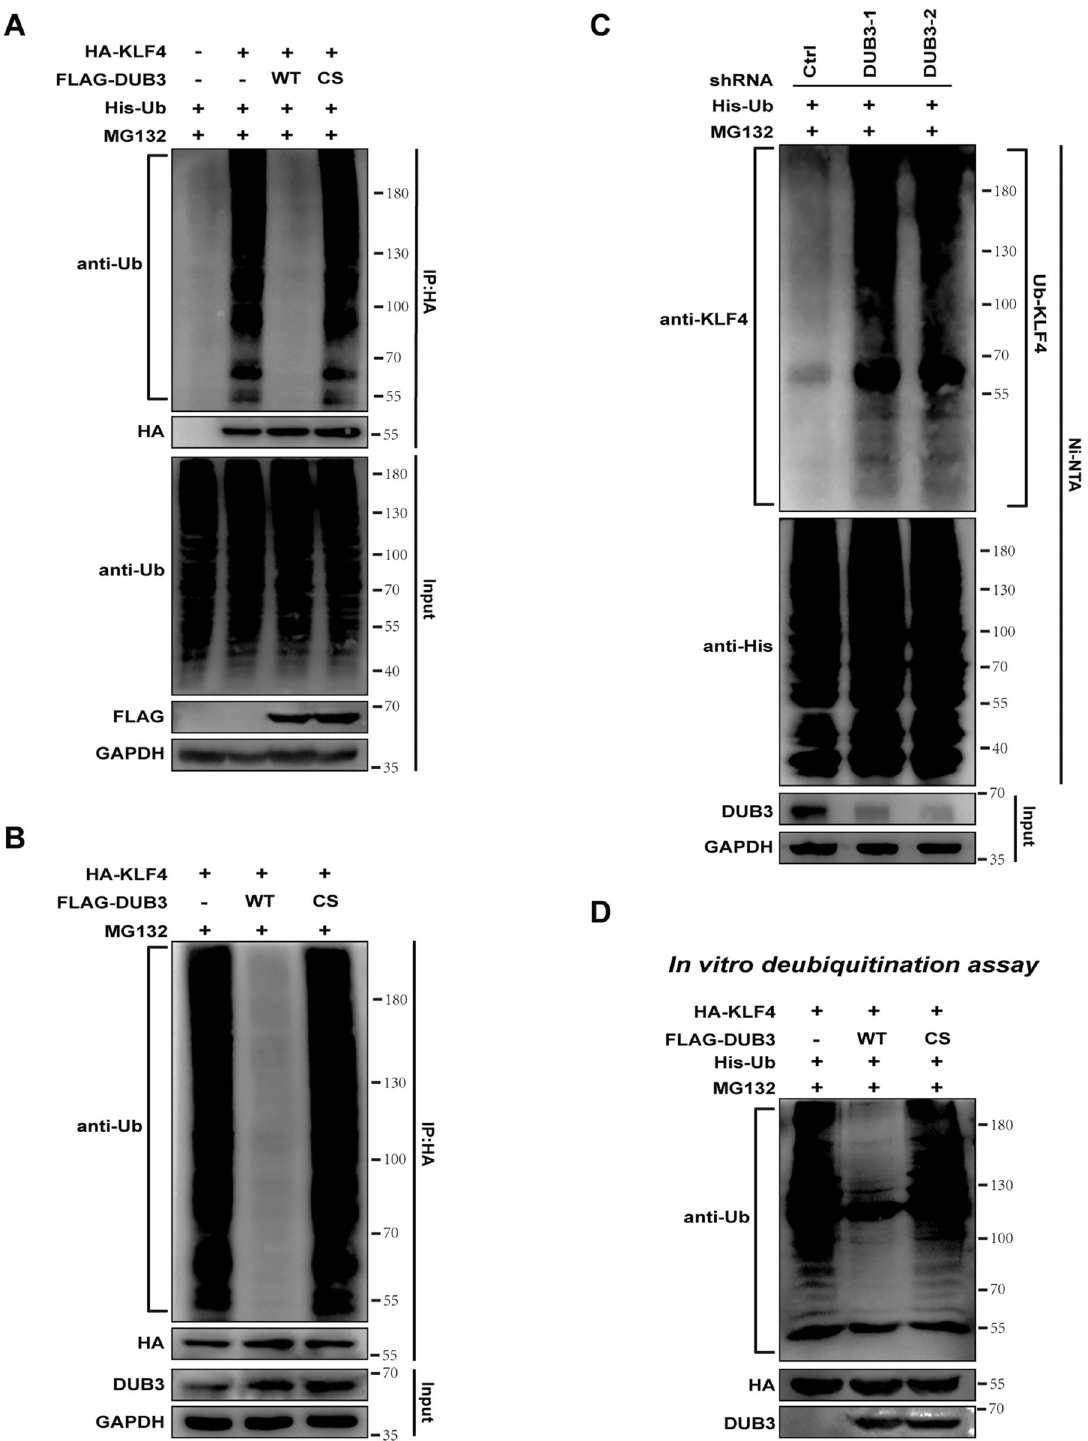
Fig. 3 DUB3 deubiquitinated KLF4 intracellularly and extracellularly. A HEK293T cells were transfected with vectors expressing HA-KLF4, wild-type FLAG-DUB3, FLAG-DUB3 mutant, or His-ubiquitin (Ub) and treated with 25 μ M MG132 for 5 h before collection. Cell lysates were immunoprecipitated with HA-tagged beads and immunoblotted to detect ubiquitin expression. B Hep3B cells were cotransfected with vectors expressing HA-KLF4 and wild-type FLAG-DUB3 or FLAG-DUB3 mutant and treated with 25 μ M MG132 for 5 h before collection. Cell lysates were immunoprecipitated with HA-tagged beads and immunoblotted to detect ubiquitin expression. C Hep3B cells stably expressing control or DUB3 shRNAs were transfected with vectors expressing His-Ub and treated with 25 μ M MG132 for 5 h before collection. Cell lysates were immunoprecipitated with Ni-NTA beads and immunoblotted to detect KLF4 expression. D HEK293T cells were cotransfected with HA- KLF4 and His-Ub. The ubiquitinated-KLF4 proteins were puri fi ed from the cell lysates under the denatured condition and incubated with wild- type DUB3 or DUB3 mutant. The complexes were blotted to detect ubiquitin, HA, and DUB3 expression.